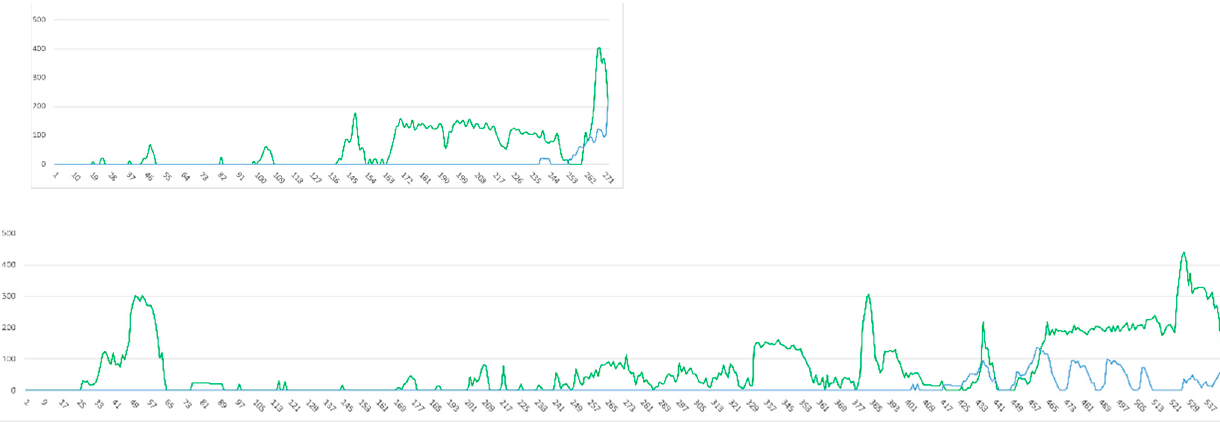
Figure 10. Geovisualization graph of case study 1 showing the green objects category type (green) and open sky category type (blue). The shortest route ( top ) and the tourism route ( bottom ).